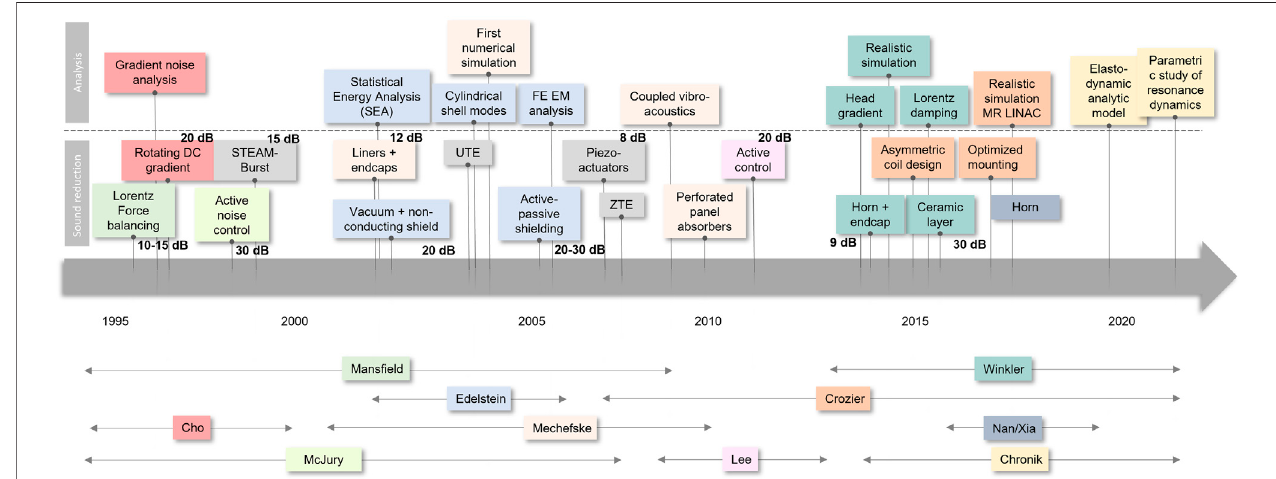
FIGURE 1 | Timeline of analytical/numerical studies and noise reduction techniques for MRI gradient